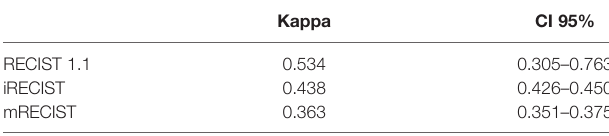
TABLE 7 | Compare the response assessment of two